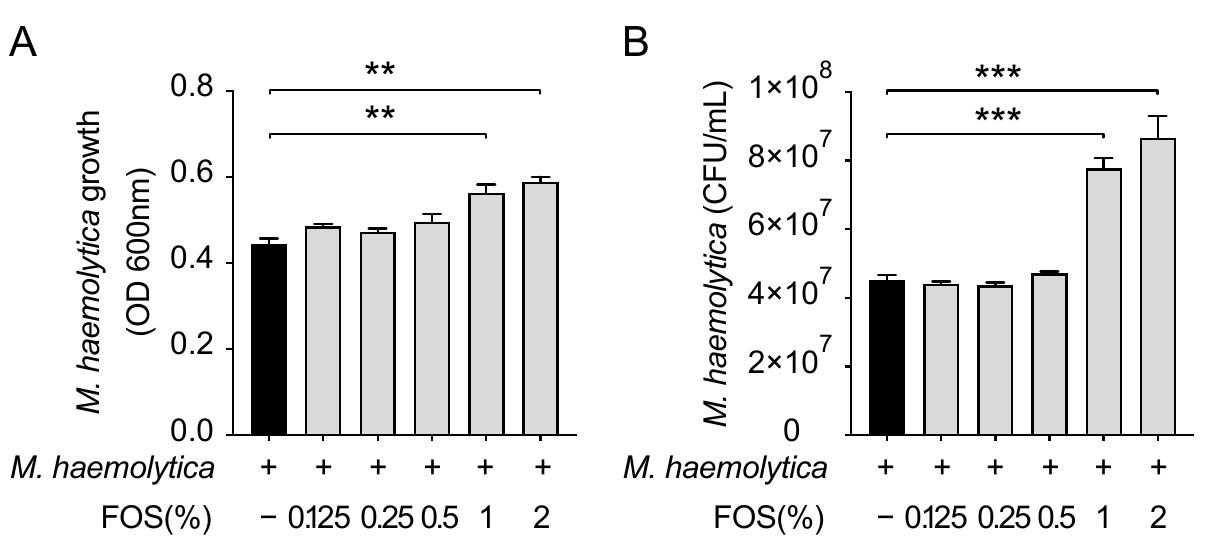
Figure 3. Effect of FOS on M. haemolytica growth in vitro. ( A ) M. haemolytica growth (OD600 nm) in the supernatant and ( B ) M. haemolytica numbers (CFUs) after subculture of supernatant on the sheep blood agar. Significantly different from M. haemolytica without FOS: ** p < 0.01; *** p < 0.001. Data are presented as means ± SEM. All data shown are representative of five independent experiments ( n = 5 bacterial generations, one generation per experiment). CFU, colony-forming unit; FOS, fructo-oligosaccharides.